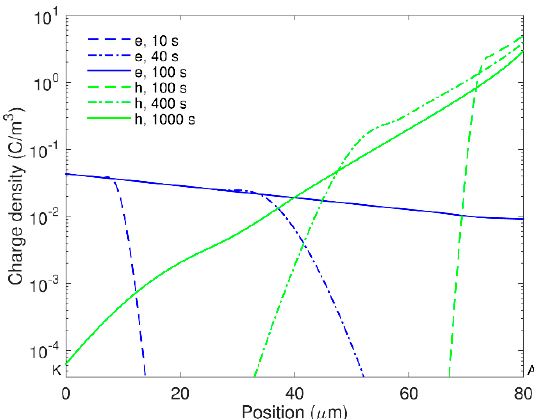
Figure 3. Density profiles of mobile electrons (e) and holes (h) in LDPE at room temperature computed at indicated time.